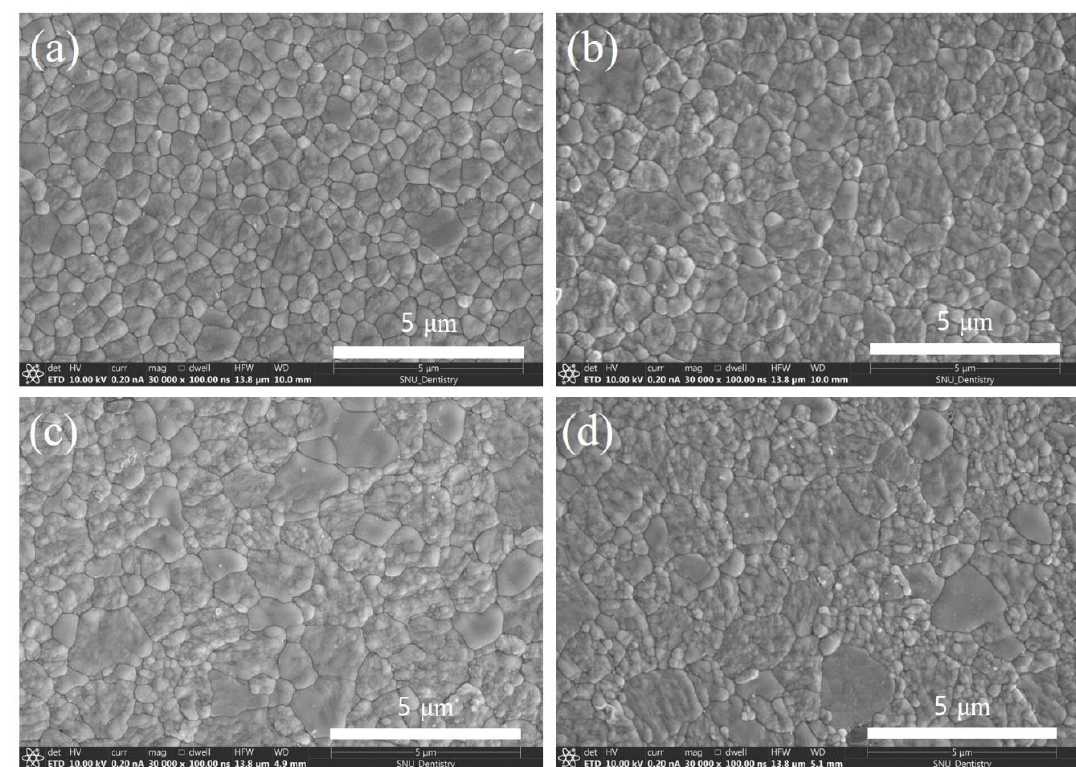
Figure 1. Scanning electron micrographs of 3Y-TZP sintered at 1550 °C for ( a ) 2 h, ( b ) 8 h, ( c ) 14 h, and ( d ) 20 h. The specimen, sintered for 2 h, shows fine grain size and well-defined grain boundaries. As the sintering time increases, the grain size increases and the grain boundaries became obscured by the disintegration of grains into pristine ones.